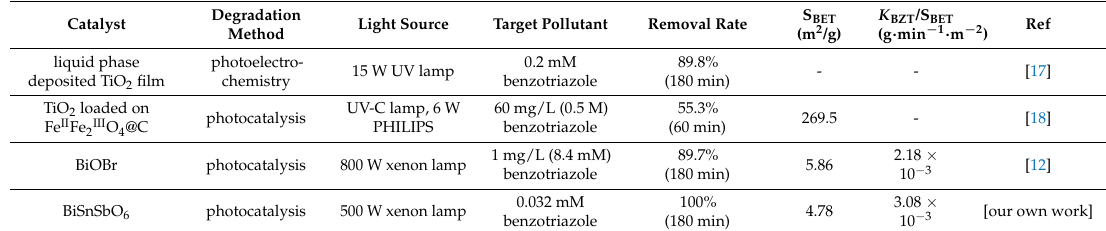
Figure 7. ( a ) Degradation curves of phenol over different samples; ( b ) Linear relation plots of ln(C 0 /C) vs. reaction time; ( c ) The photodegradation rate constants ( k ) calculated from ( b ). Table 2. The photocatalytic activity results from the literature data on BZT degradation compared with this